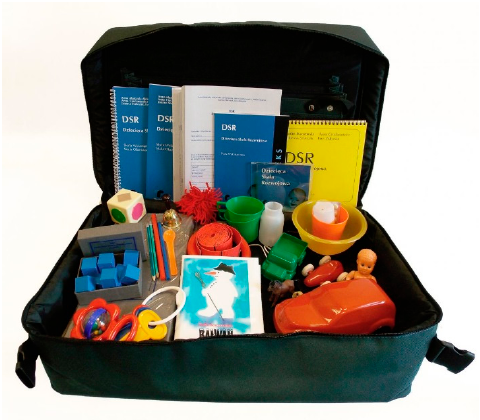
Figure 2. The Children Development Scale DSR Kit [50].